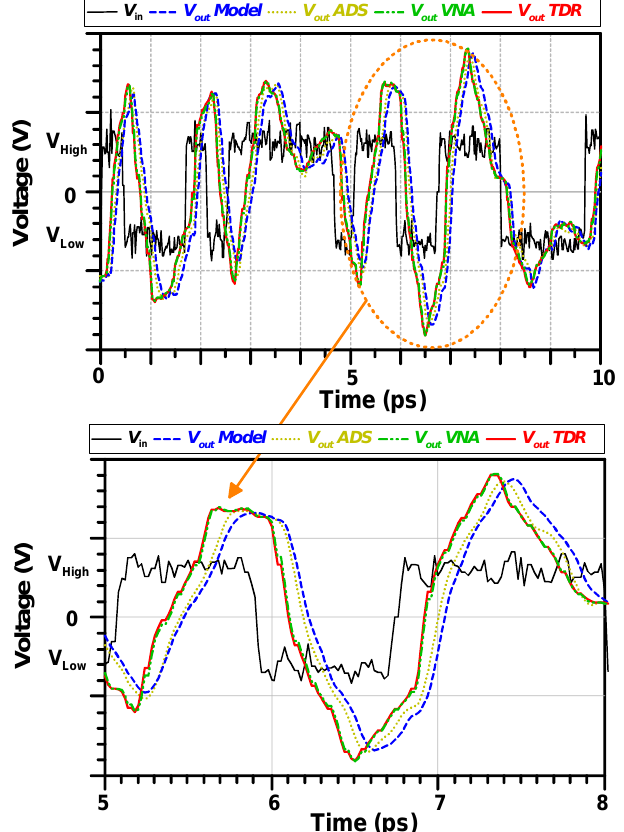
Figure 7: Comparison between the different techniques for a NRZ noisy 2.38 Gpbs input signal.